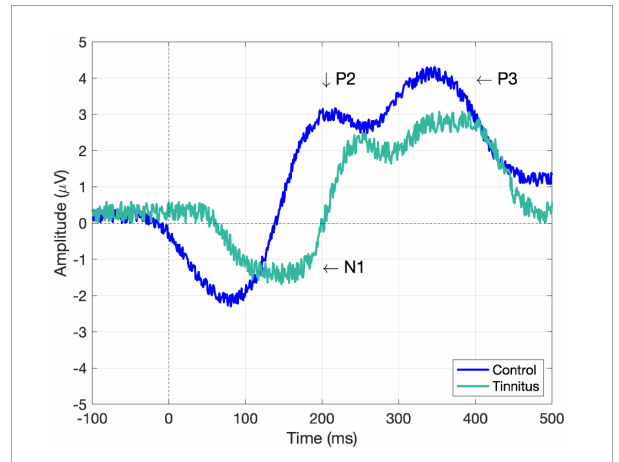
FIGURE1 Simulated AERP components (N1, P2, and P3) of tinnitus and healthy controls. The approximated values according to the previous literature are the following: N1 for control (–2.2 µ V, 80 ms) and tinnitus (–1.7 µ V, 150 ms), P2 for control (2.9 µ V, 207 ms) and tinnitus (2.4 µ V, 250 ms), and P3 for control (4 µ V, 340 ms) and tinnitus (2.6 µ V, 380 ms). Note, amplitude and latencies could vary according to the applied methodology. Control is depicted in blue and tinnitus in cyan (greenish